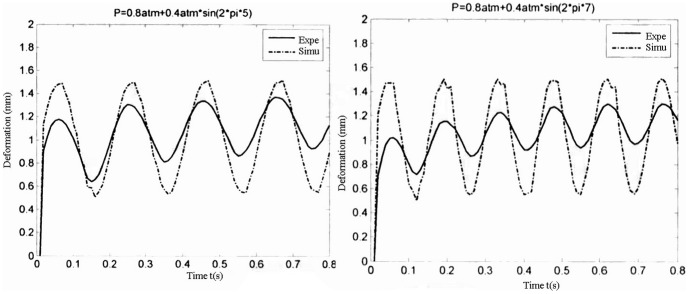
Finger deformation with 5 and 7